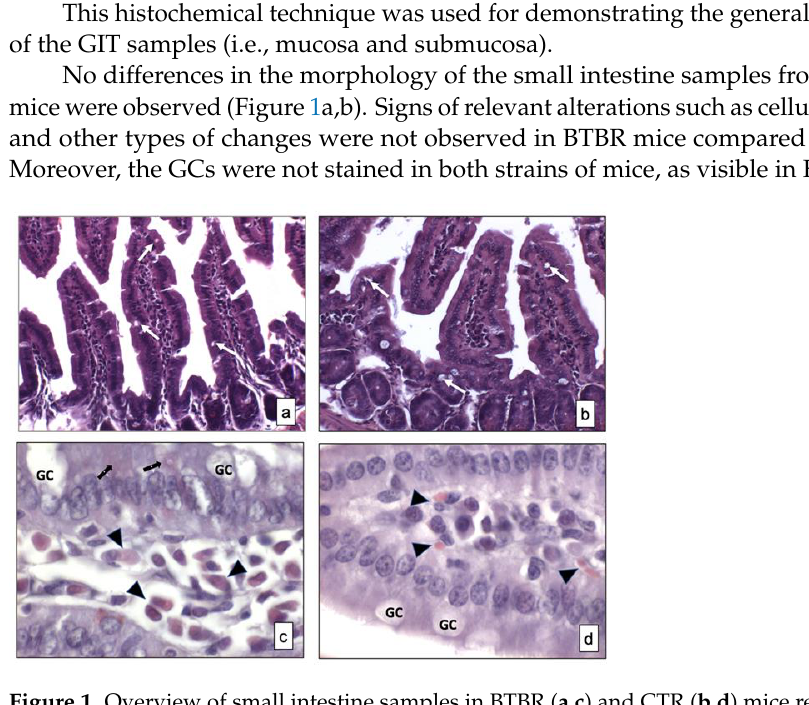
Figure 1. Overview of small intestine samples in BTBR ( a , c ) and CTR ( b , d ) mice respectively stained using hematoxylin and eosin and Xylidine-Ponceau techniques. Goblet cells are indicated as white arrows in ( a , b ) and as GC in ( c , d ); Lymphatic cells (i.e., plasma cells) are indicated with arrowheads in ( c , d ); Epithelial cells are indicated as black arrows in ( a , b ). ( a , b )—200 × ; ( c , d )—1000 × . The number of animals was 10 for BTBR and 10 for CTR; moreover, three samples for each animal were used. The images are a representative sample of all the tissues